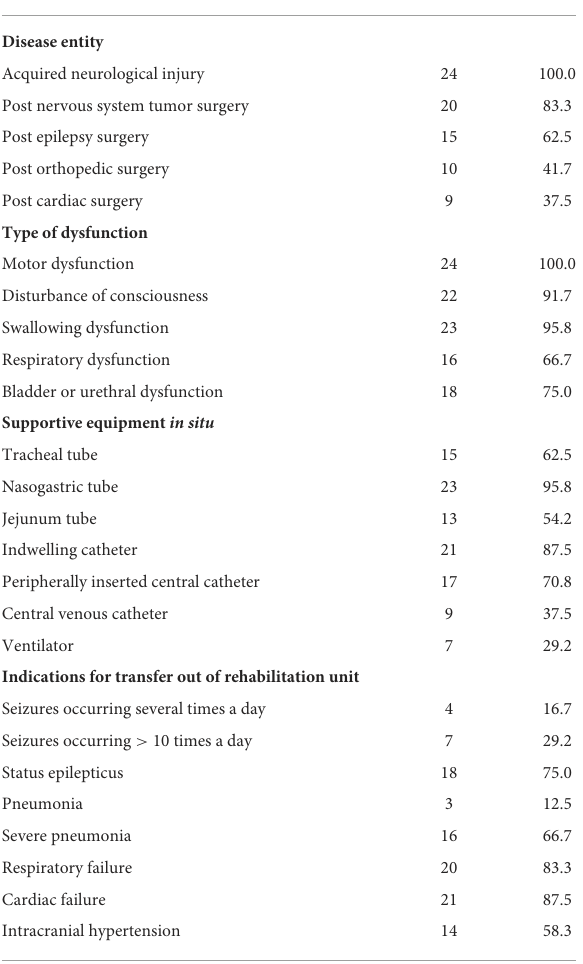
TABLE 2 Treatment capacity of 24 specialized centralized units implementing early rehabilitation for critically ill